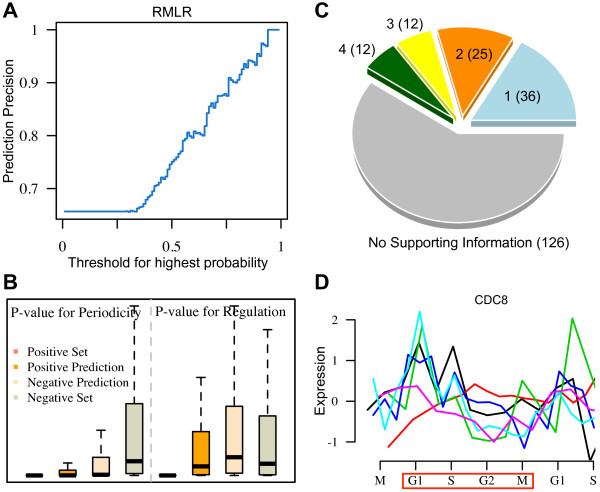
Multiple phase prediction model and cell cycle gene prediction. (A) Performance of regularized multinomial logistic regression (RMLR) in separating phase specific cell cycle genes. (B) PPer (p value for periodical) and PReg (p value for regulation) for different gene sets: known cell cycle gene set, predicted cell cycle gene set, predicted non-cell cycle gene set and known non-cell cycle gene set. (C) Support from other studies. (D) Expression profiles of CDC8 from 6 experiments in Cyclebase. Red rectangle denotes the second induced cell cycle.